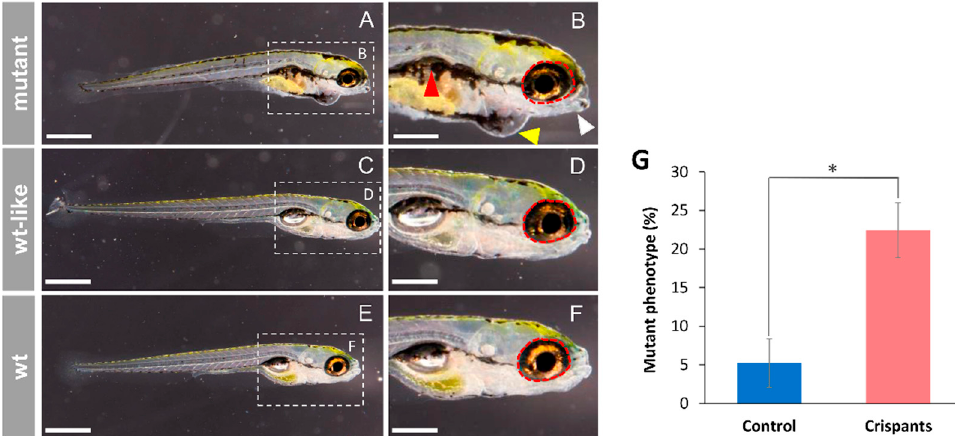
Figure 3. Cyp1b1 F0 crispants’ phenotypes (144 hpf). ( A – D ) One-cell embryos were microinjected with CRISPR/Cas9 ribonucleoprotein complexes targeting cyp1b1 exon 1. Crispants’ morphology was assessed microscopically at 144 hpf. ( E , F ) Non-injected larvae were used as controls (wt). White arrow: lower jaw underdevelopment. Red arrowhead: altered swim bladder development. Red dotted circle: wildtype ocular periphery is indicated as a reference to show microphthalmia. Yellow arrowhead: pericardial edema. Scale bar in ( A , C , E ) = 500 µm. Scale bar in ( B , D , F ) = 250 µm. ( G ) Proportion of F0 mutant phenotypes. The controls were microinjected with all CRISPR/Cas9 reagents except crRNAs. Asterisks indicate statistical significance compared to the control, p < 0.05 (*). The values correspond to the means ± SEM of three independent experiments (50–80 embryos per group and experiment).